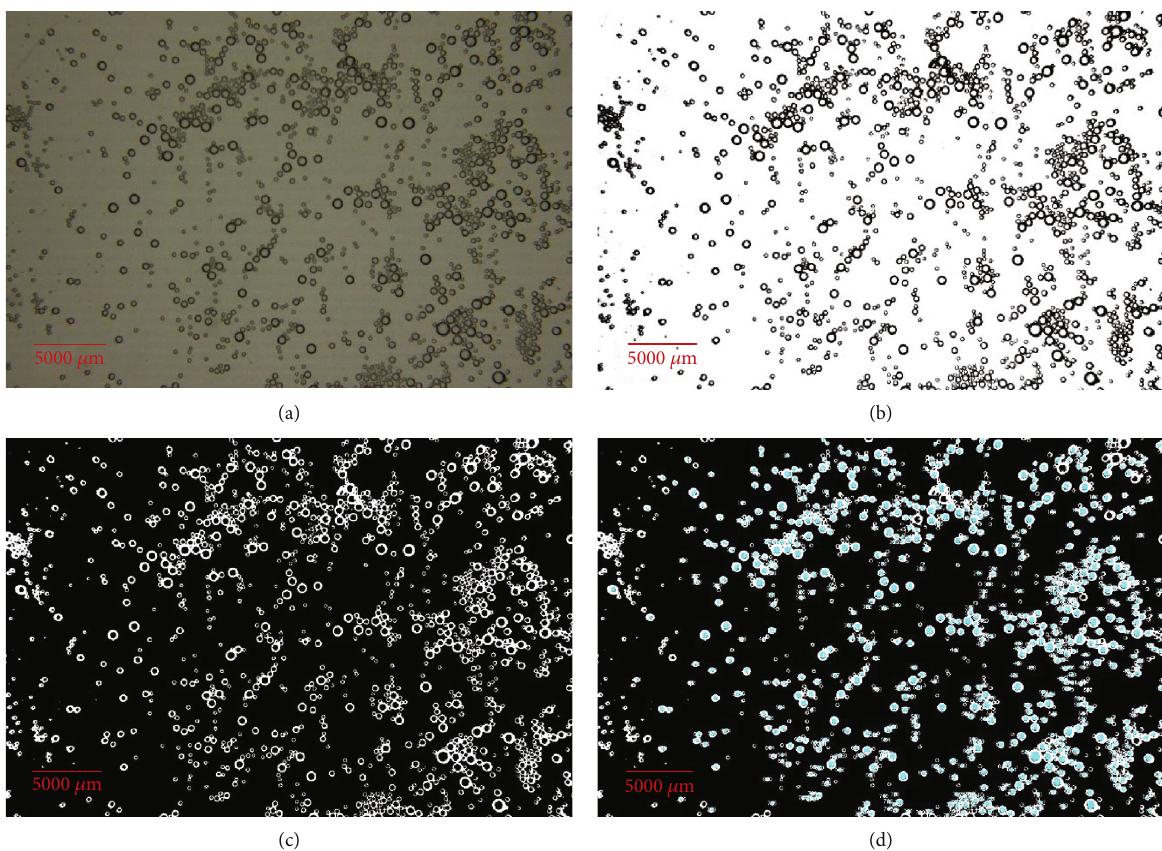
Figure 3: The upgraded image analysis for solving densely binding bubbles: (a) the original image, (b) the binary image, (c) the inverted binary images, and (d) the identi fi cation of the bubble bright centroids (highlighted in